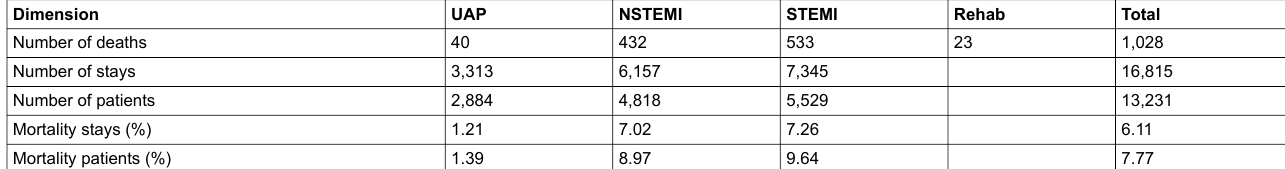
Table 2: In-hospital mortality due to ACS in 2008 (per stays and per patient). Own calculation on MedStat [11]. In-patient hospital stays include at least 1 night spent in hospital. Deaths occurring in the emergency room are thus excluded from this number.184 patients died during the first day of stay. Mortality rates differ significantly if calculated per number of stays or number of patients.